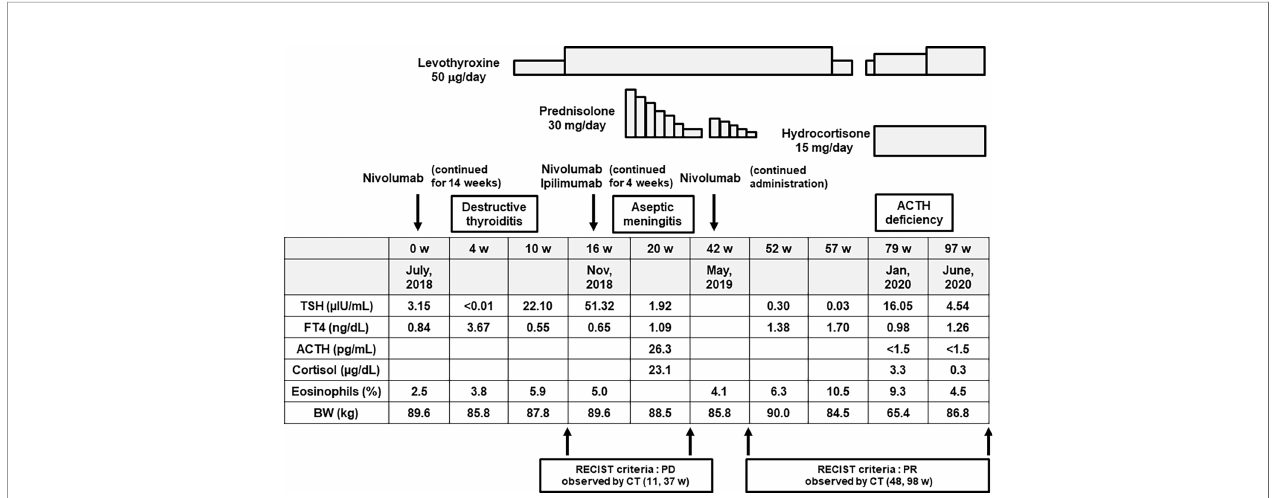
FIGURE 1 | Time course of the clinical parameters, diagnosis, and treatment for this subject. Firstly, about 4 weeks after starting nivolumab monotherapy for malignant melanoma, he suffered from destructive thyroiditis, and so we started replacement therapy with levothyroxine. Secondly, about 4 weeks after starting combination therapy of nivolumab and ipilimumab, he suffered from aseptic meningitis. Thereafter, we stopped both drugs and started steroid therapy with prednisolone. Finally, about 9 months after starting nivolumab, he suffered from isolated adrenocorticotropic hormone (ACTH) de fi ciency, and so we started replacement therapy with